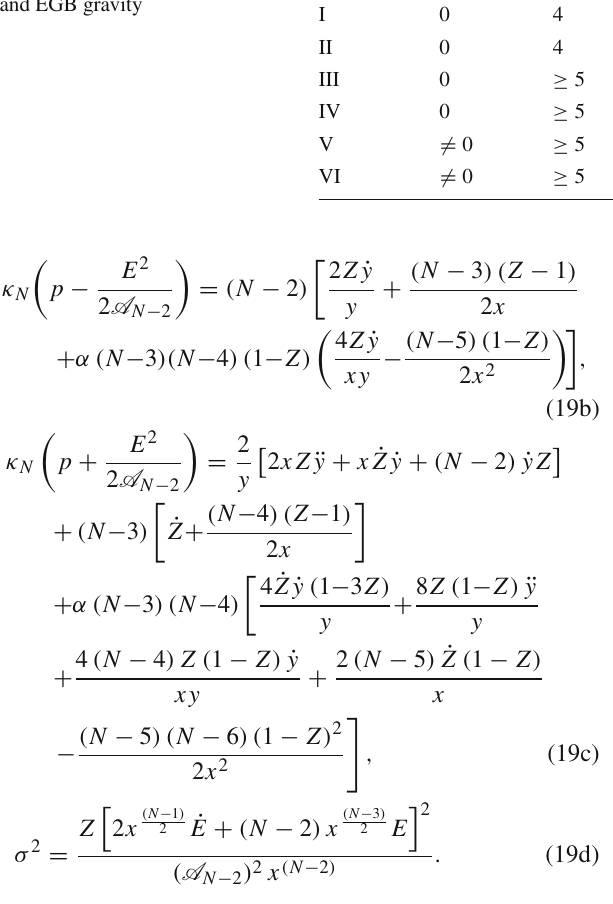
Table 1 Fluids with isotropic pressures in general relativity and EGB